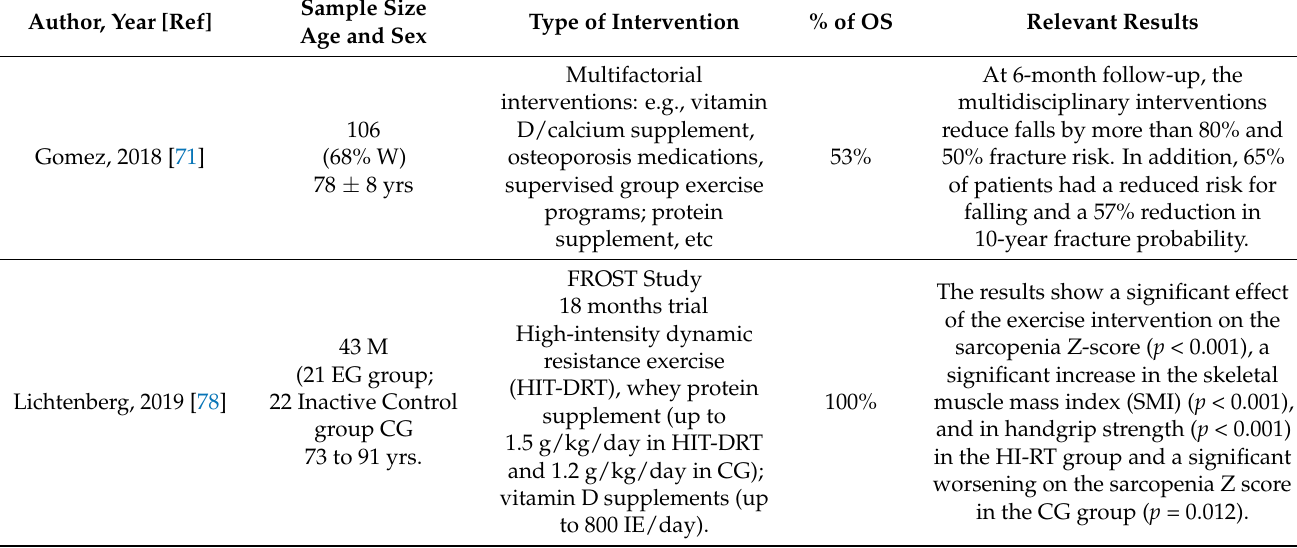
Table 2. Relevant results on Osteosarcopenia (OS) subjects in Non-Pharmacological